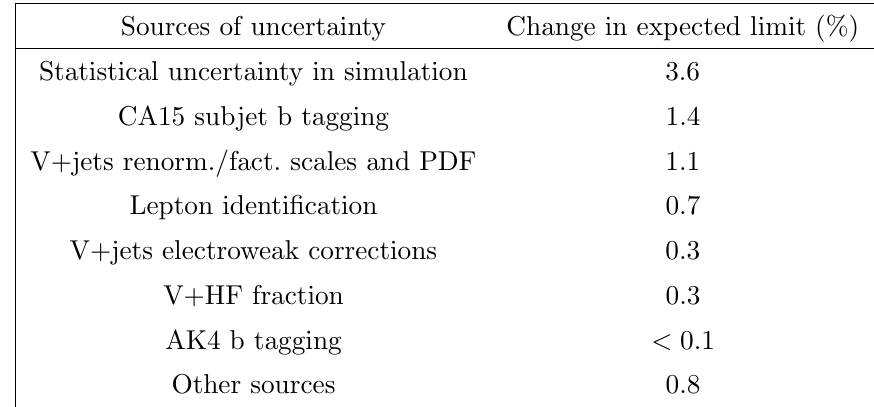
Table 2 . Importance of groups of systematic uncertainties, as measured by the sensitivity of this search to a benchmark FCNC model ( m V = 2 : 25 TeV ; m (cid:31) = 1 GeV). The importance is assessed by evaluating the relative change of the expected 95% CL limit after removing each group of uncertainties. \Other sources" includes all uncertainties not considered elsewhere in the table.